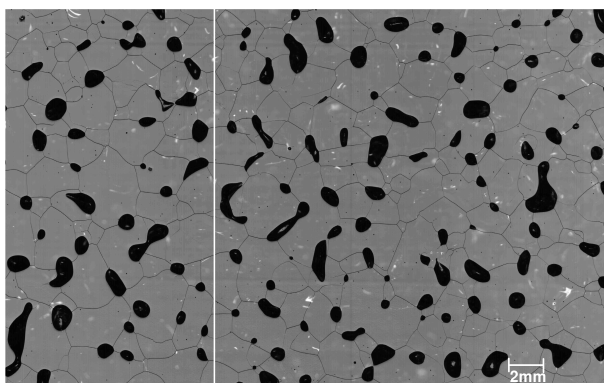
Figure 3. Location of the examined ice core B34. Figure 2. Cross section of ice core showing the sample location pattern.